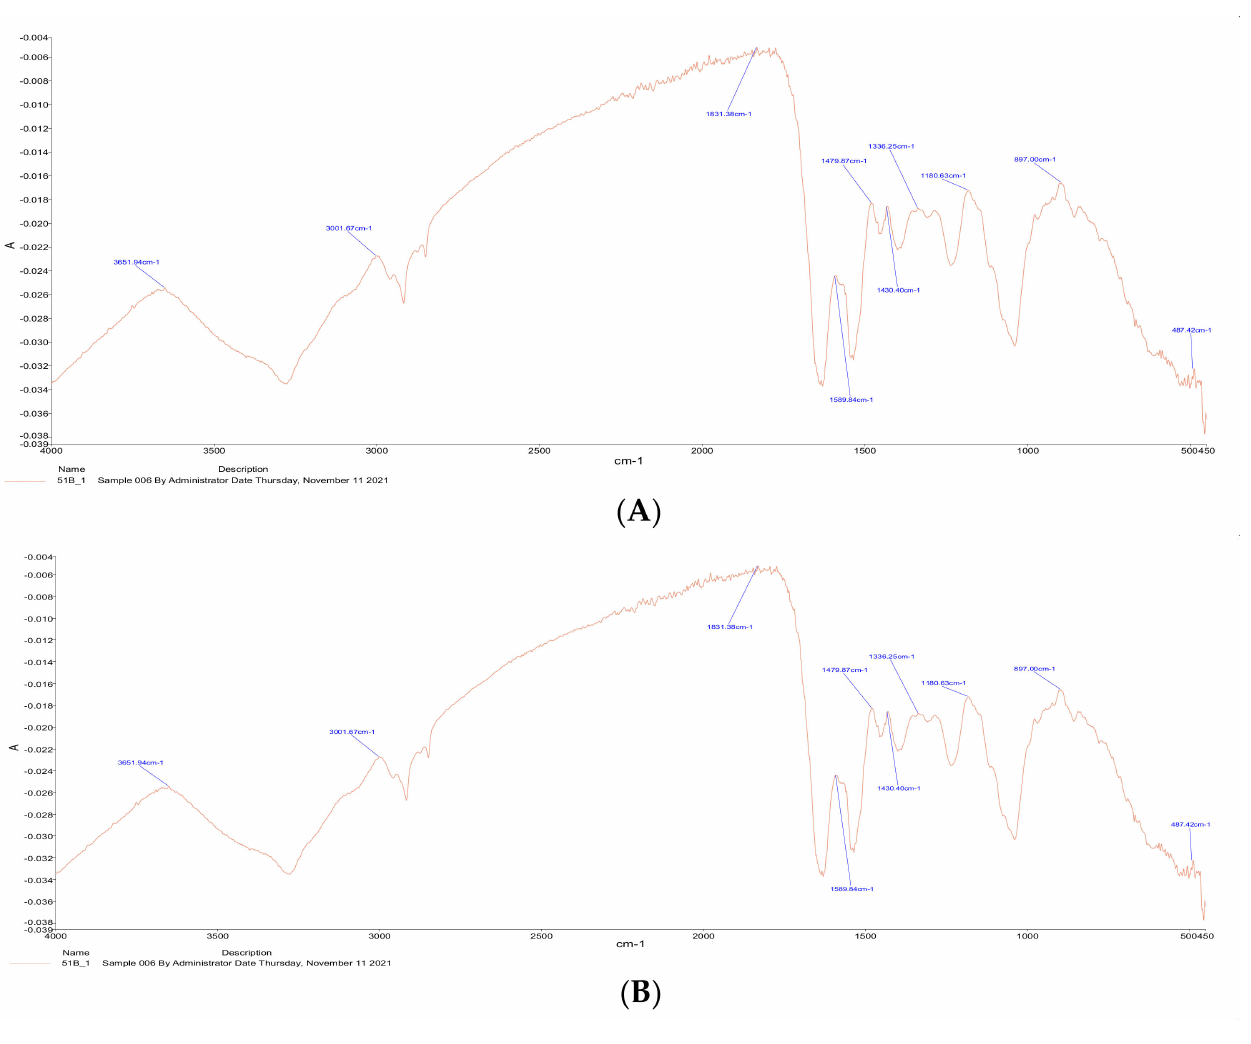
Figure 3. FTIR spectra of S. lutetiensis ( A ) and L. plantarum ( B ) label for ( A , B